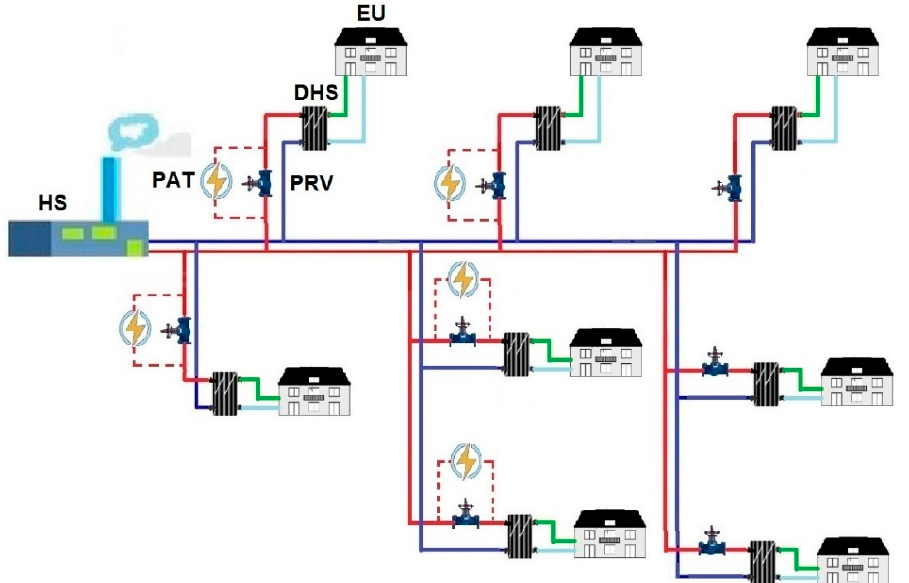
Figure 10. Typical micro hydro-turbine locations in a DHS: HS—heating station; PRV—pressure reducing valve; DHS—district heating substation; EU—end-user; PAT—pump as turbine.